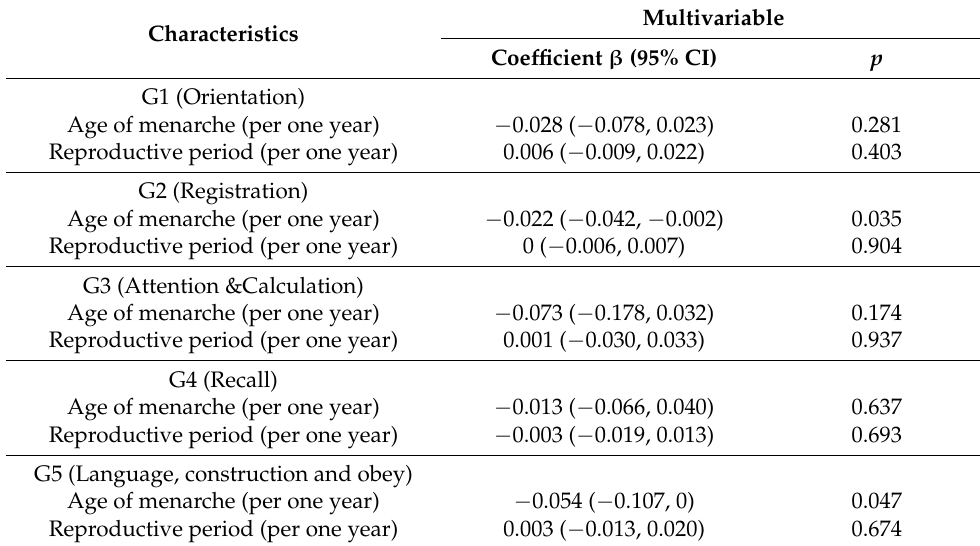
Table 5. Association of menarche age and reproductive period with MMSE subscores using multi- variable linear regression